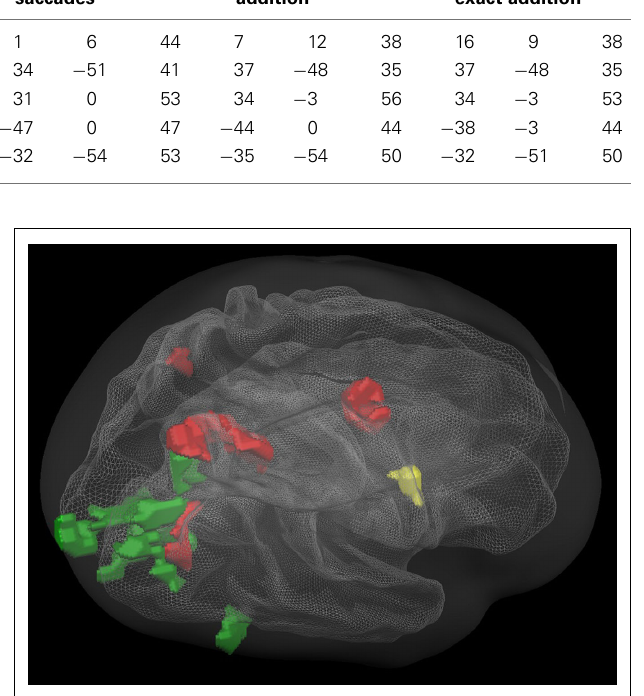
found were highly similar to the findings reported for the